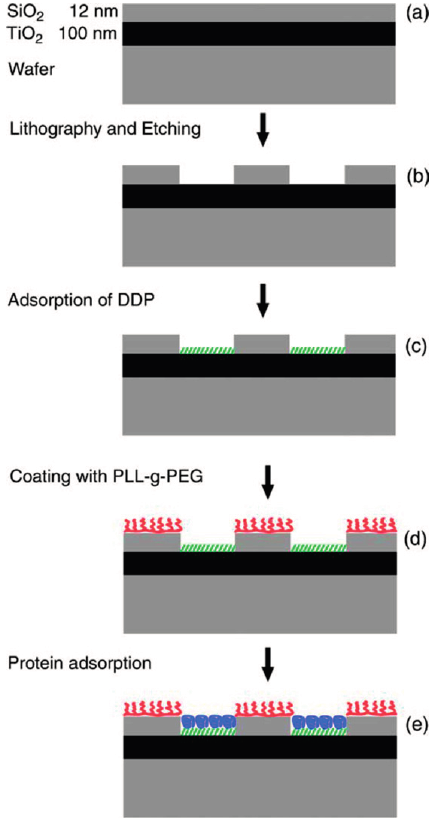
Figure 5. Schematic illustration of the original SMAP method [79]. Material contrast created in oxides by lithographic techniques is converted, in a series of dip-and-rinse processes performed in aqueous solutions, into a contrast with respect to protein adsorption: ( a ) a polished silicon or transparent glass wafer is coated first with a 50 nm titanium oxide intermediate layer and then with a 12 nm thin silicon oxide top layer; ( b ) The desired patterns are created in the metal oxide layer by a combination of lithographic and etching processes; ( c ) Adsorption of dodecyl phosphate (DDP) from aqueous solution leads to the formation of an oriented self-assembled monolayer on TiO 2 , making it hydrophobic. There is no interaction between DDP and the SiO 2 surface, which is left completely bare; ( d ) After rinsing with water, PLL- g -PEG adsorbs from a buffered solution to the bare SiO 2 , and to a lesser extent also to the DDP (not shown). After rinsing, the PLL- g -PEG-coated SiO 2 regions repel proteins completely, while the PLL- g -PEG adsorbed on the DDP is weakly bound and is exchanged with the adsorbing protein(s); ( e ) The chemical contrast between hydrophobic and protein-resistant areas can then be converted into an adhesive/biofunctional contrast by simply exposing the surface to